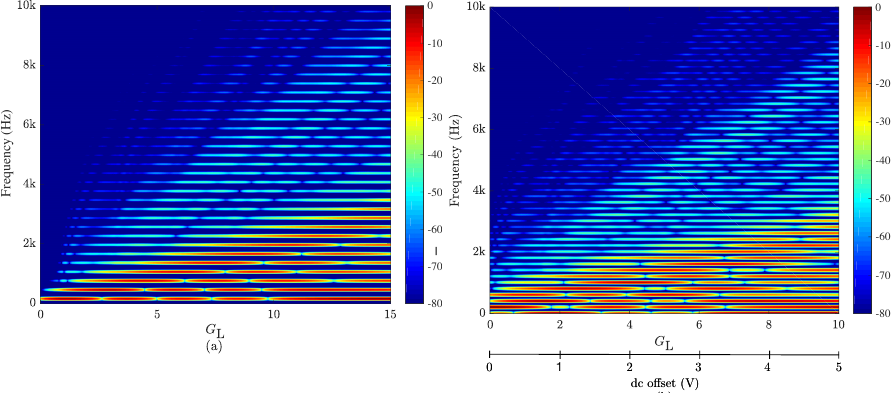
Figure 21. Spectrogram of: ( a ) a 150-Hz sinewave with peak amplitude 1V processed by the proposed cascaded Lockhart topology with varying gain G L from 0 to15; and ( b ) a 200-Hz sinewave processed with varying gain G S from 0 to 0 and dc offset from 0 to